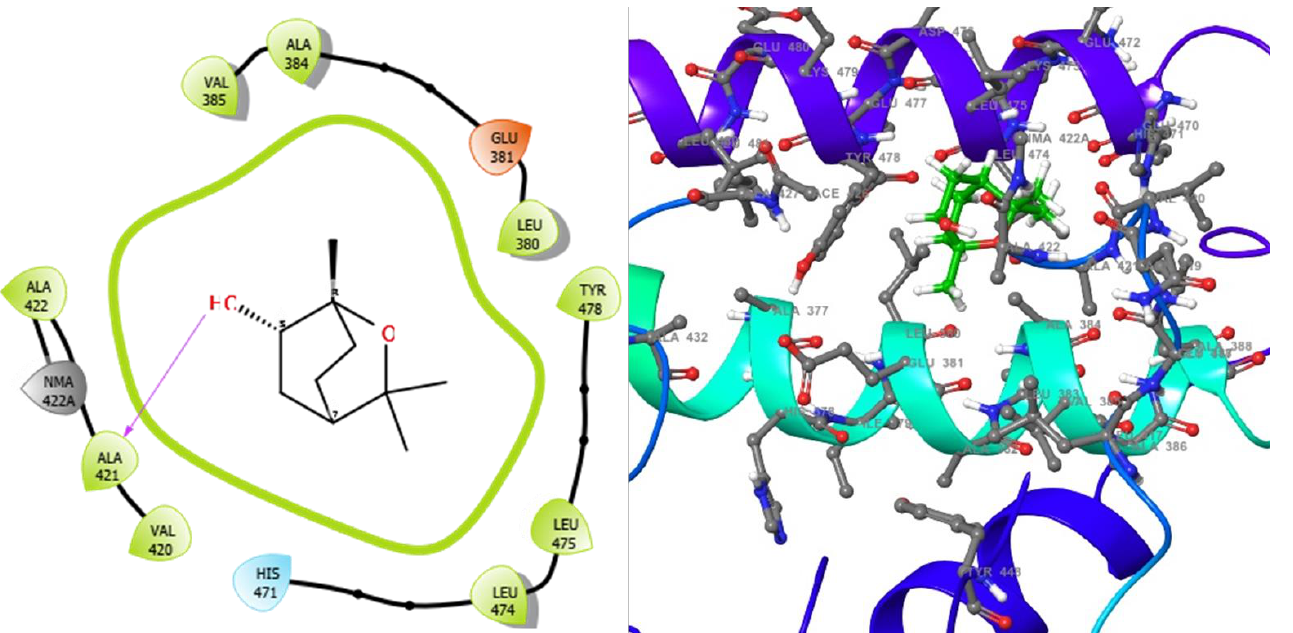
Figure 7. 2D ( left ) and 3D ( right ) views of the molecular interactions at the surface of the active site of receptor E. coli DNA gyrase–DNA binding and cleavage domain in State 1 binding with 1,3,3- trimethyl-2-oxabicyclo[2.2.2]octan-6-ol (the green stick model). The negative, positive, and neutral charges of the binding site residues are represented with red, blue, and white colors, respectively. Table 6. MD simulation properties of the native protein and of the protein–ligand interactions.